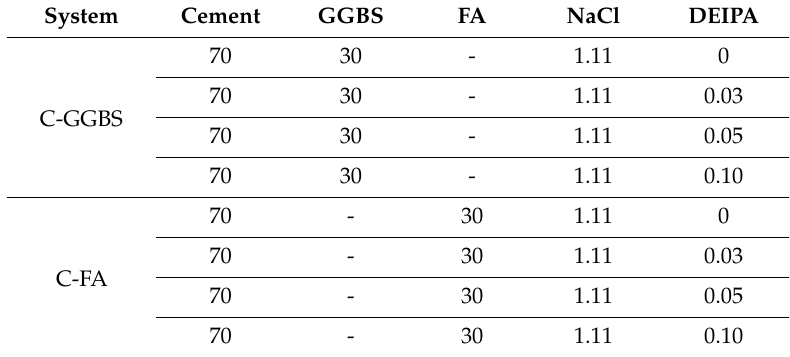
Table 2. Mix proportions of samples